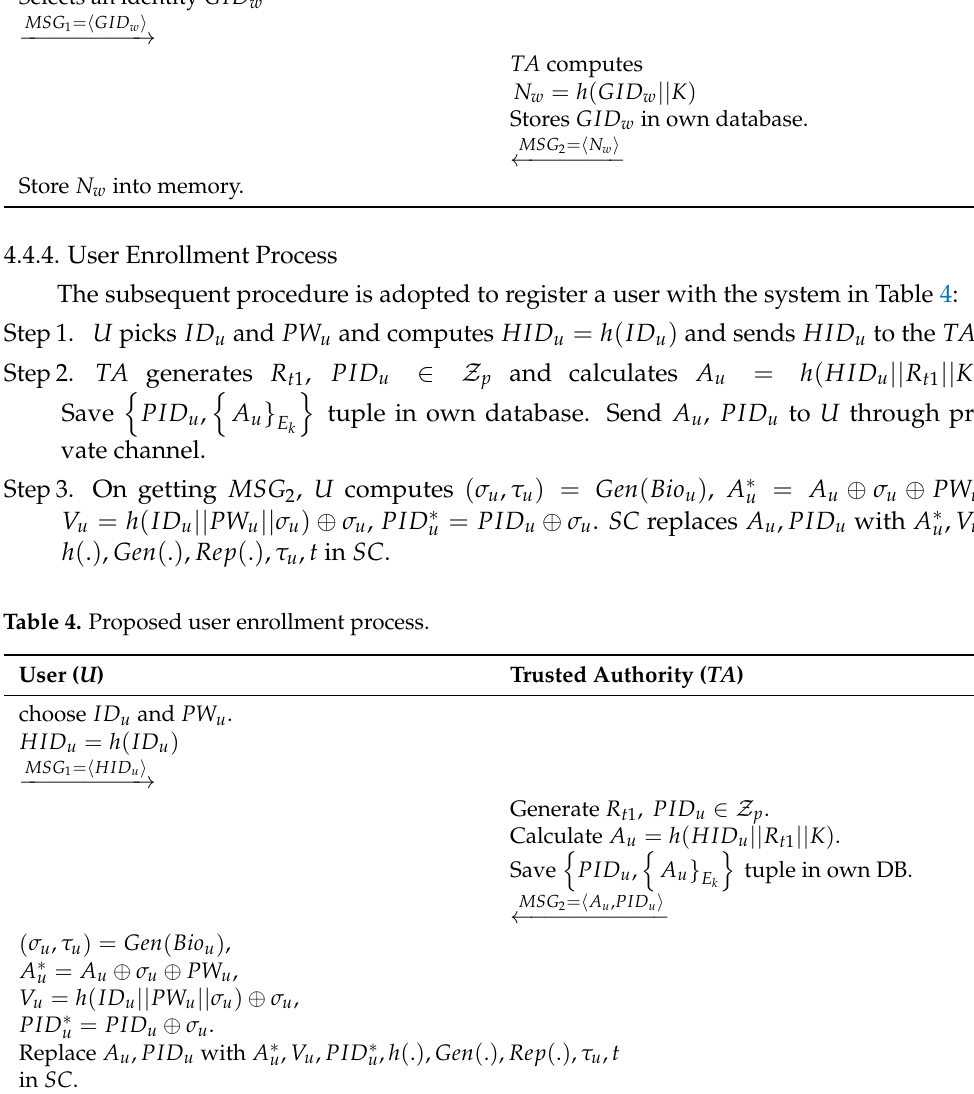
Table 3. Proposed gateway node enrollment process. Gateway Node ( GWN )